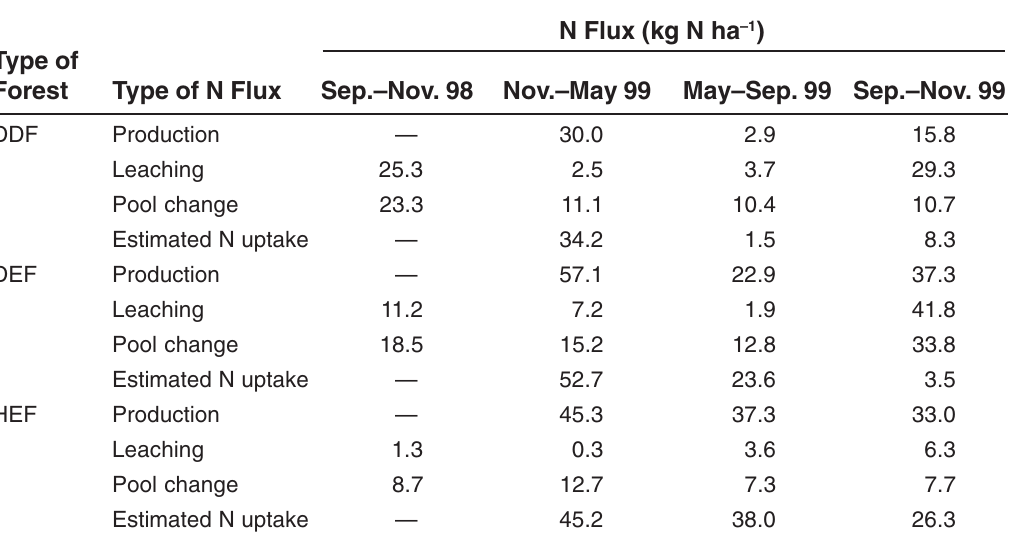
N Flux (kg N ha –1 )